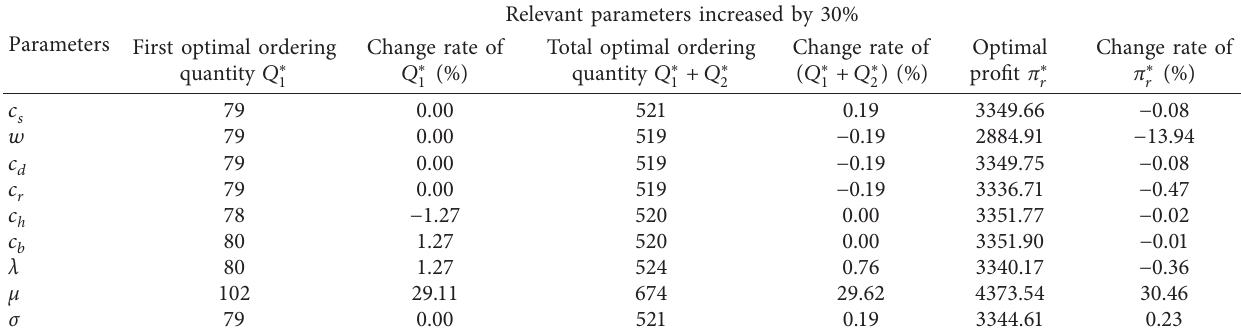
Table 4: The parameters’ influence on the optimal ordering quantity and profit without RFID.